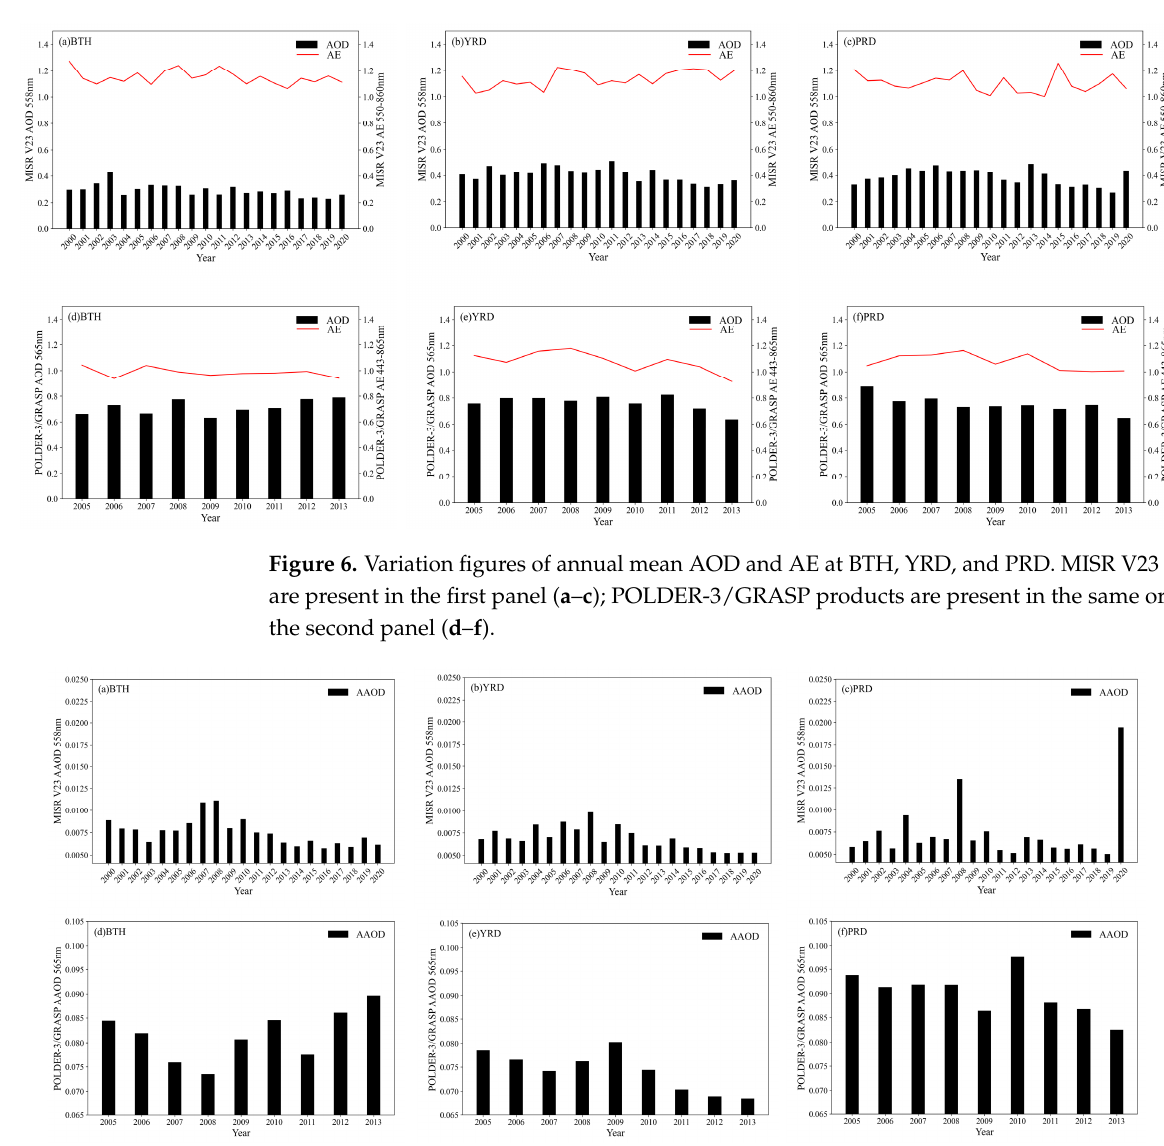
Figure 7. Variation figures of annual mean AAOD at BTH, YRD, and PRD. MISR V23 products are present in the first panel ( a – c ); POLDER-3/GRASP products are present in the same order as in the second panel ( d – f ).